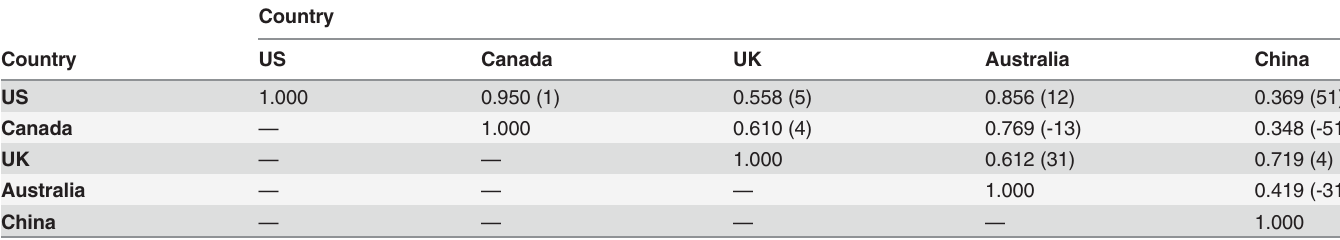
Table 2. The pairwise cross-correlations of seasonal components of search trends regarding lung